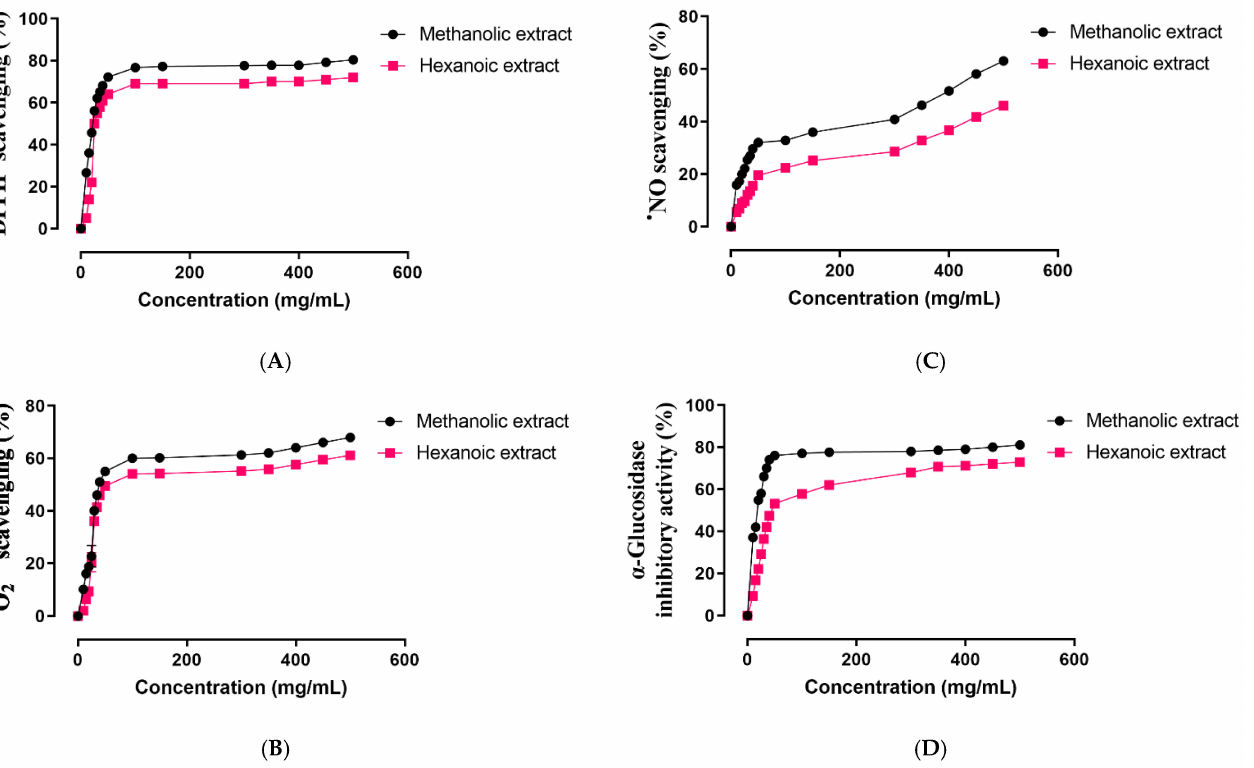
Figure 2. Effect of methanolic and hexanoic extracts of S. androgynus leaves against ( A ), DPPH • : 1,1-diphenyl-2-picrylhydrazyl; ( B ), O 2 •− : superoxide; ( C ), • NO: nitric oxide; ( D ), α